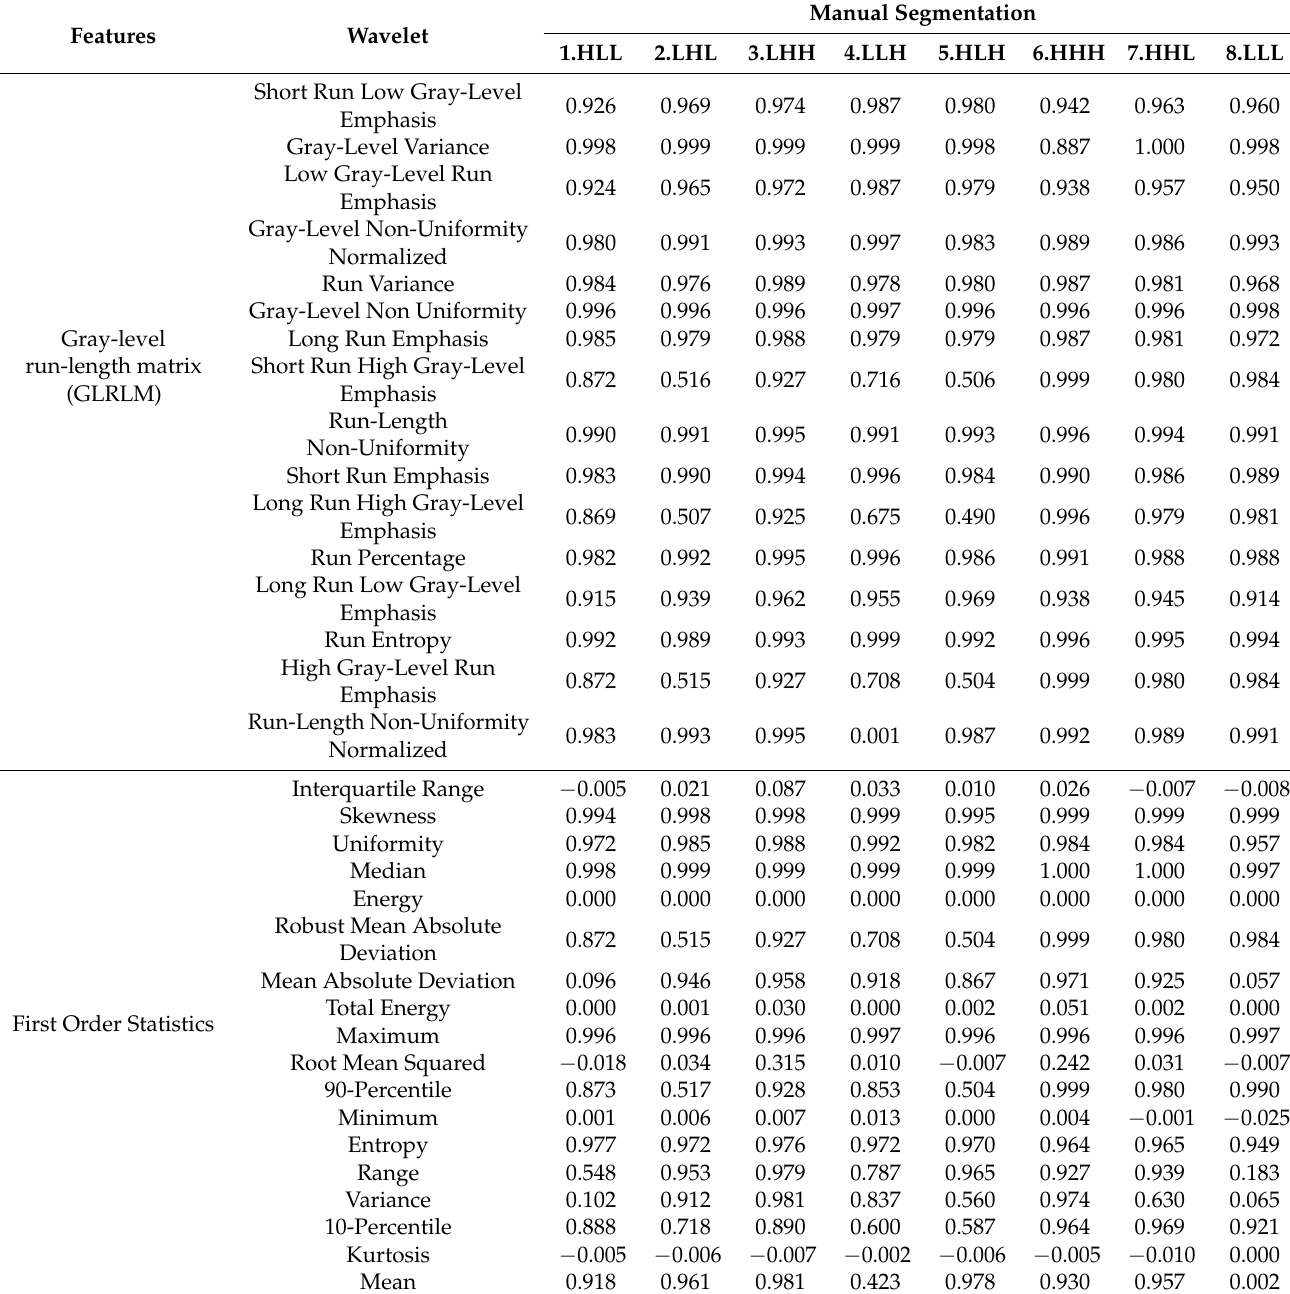
Table 4. Wavelet features for manual